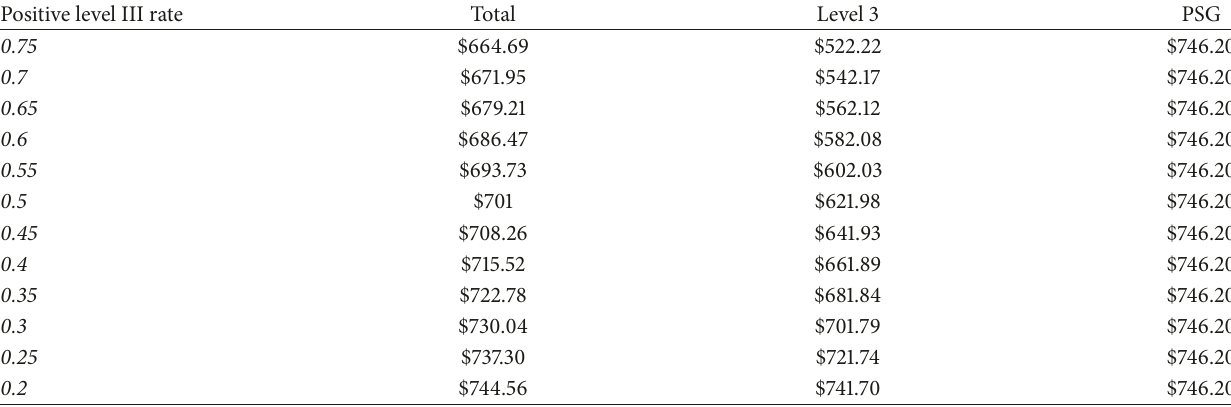
Table 5: Investigating the effect of reducing the positive level III test rate on patient